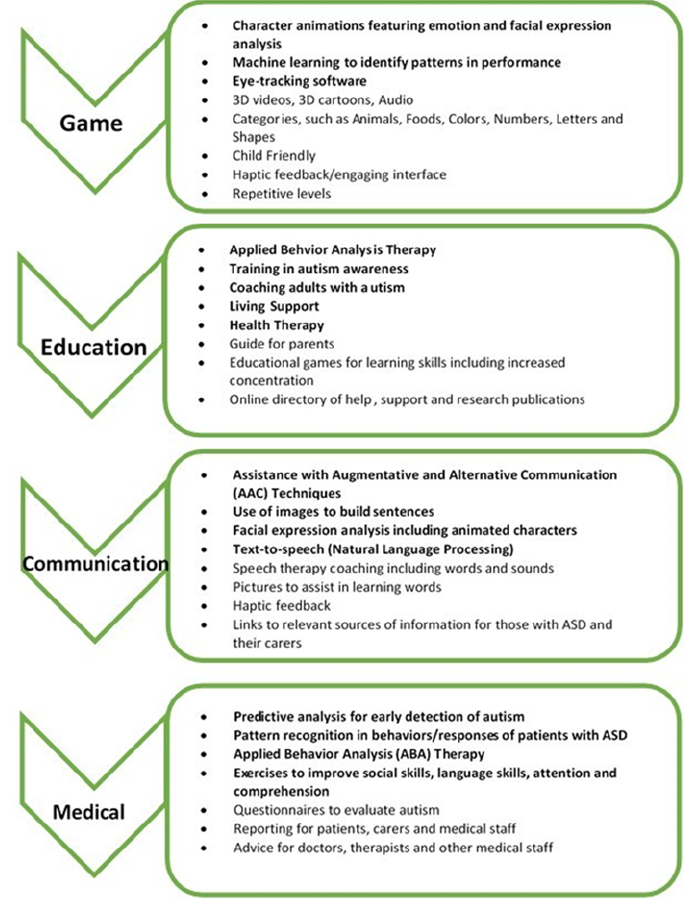
Figure 7. Features identified from the literature and mobile